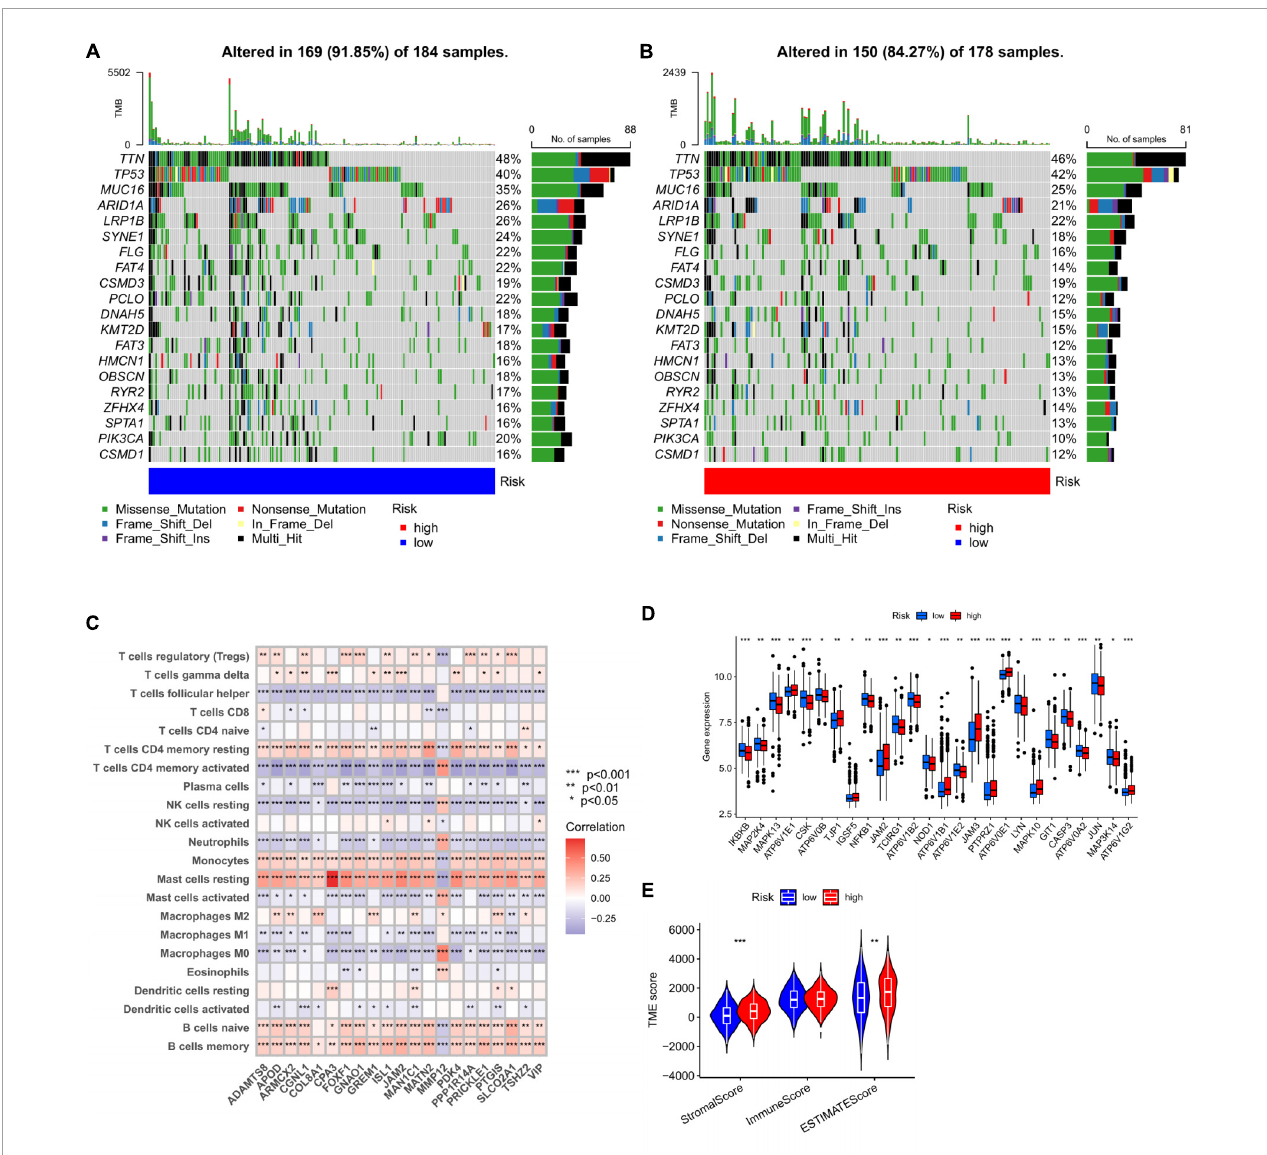
FIGURE9 Exploring the factors influencing the prognosis of different groups. (A,B) The waterfall plot of somatic mutation features constructed with high- and low-risk groups. (C) Correlations between the abundance of immune cells and 21 genes in the prediction model, * p < 0.05, ** p < 0.01, and *** p < 0.001. (D) Expression distributions between high- and low-risk groups in HGRs. (E) The correlations between risk and TME score. TME, tumor